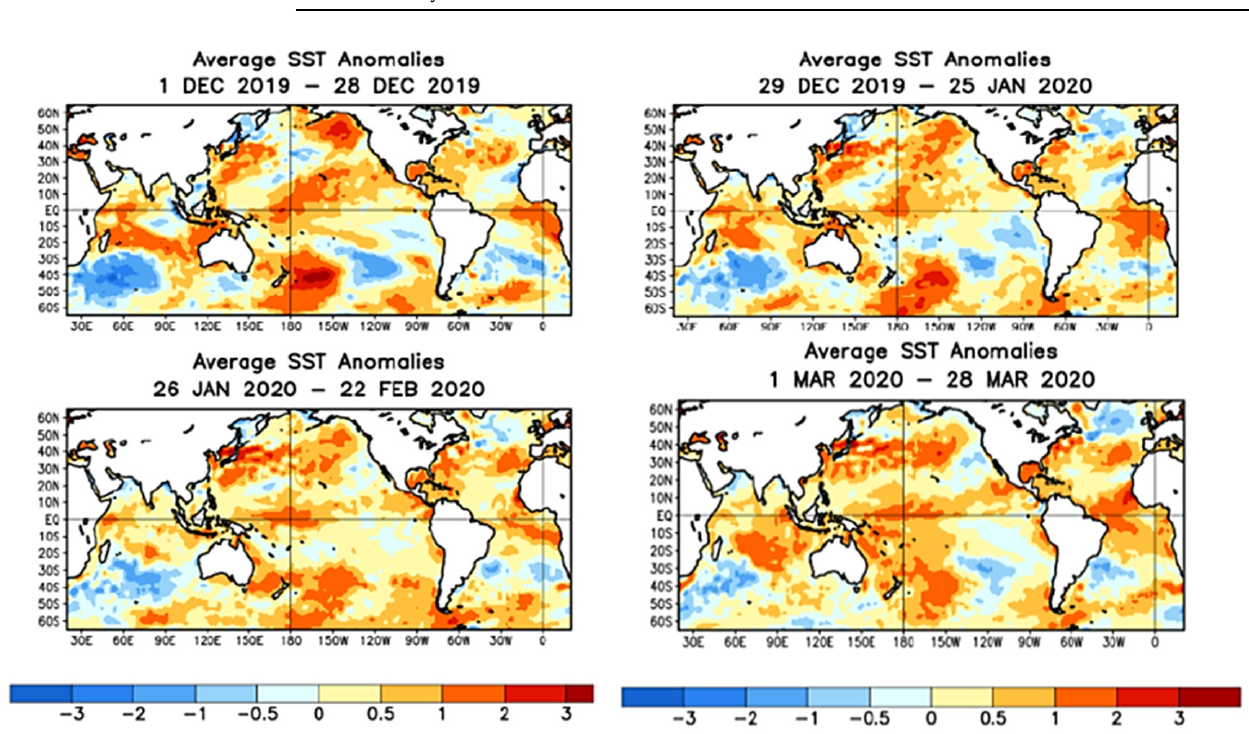
Figure 30. Sea surface temperature anomalies between 1 December 2019 and 28 March 2020.